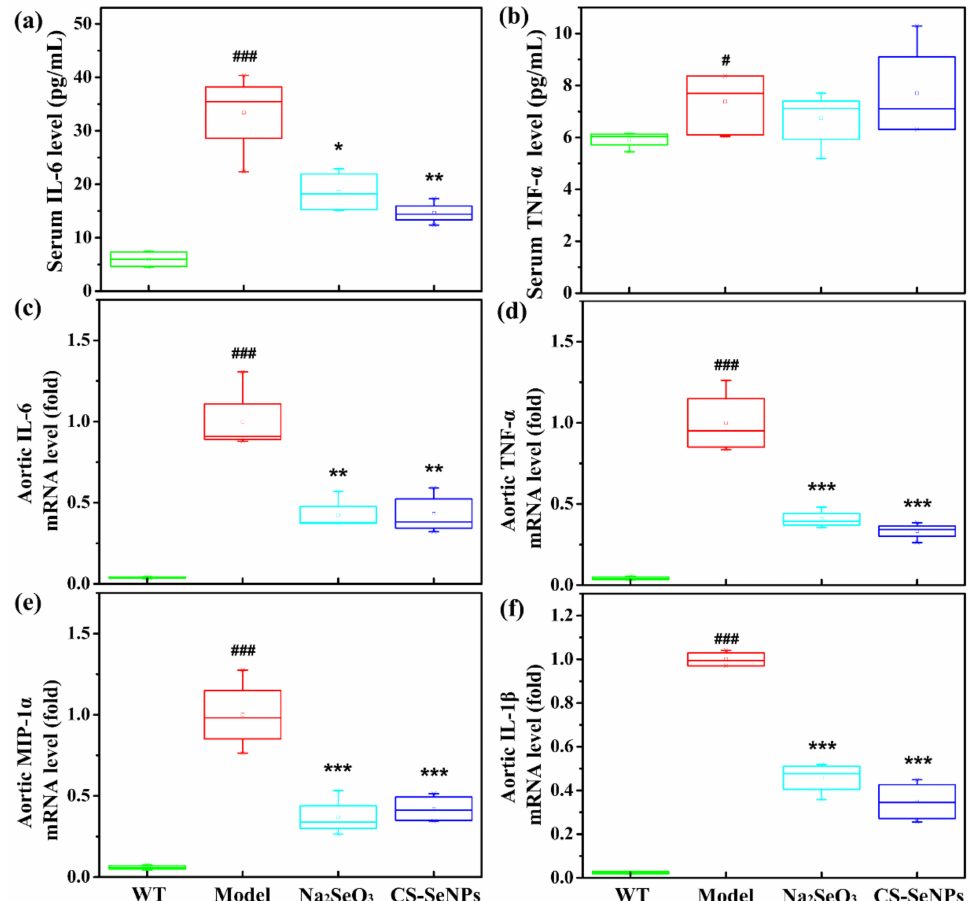
Figure 7. CS-SeNPs and Na 2 SeO 3 inhibited inflammatory response in serum and the aorta. ( a , b ) The levels of serum IL-6 and TNF- α , assayed by ELISA ( n = 8–10); ( c – f ) the mRNA expression levels of IL-6 ( c ), TNF- α ( d ), MIP-1 α ( e ) and IL-1 β ( f ) in the aorta, assayed by qPCR ( n = 4–5). The results were expressed as mean ± SD. # p < 0.05, ### p < 0.001, compared with the WT group. * p < 0.05, ** p < 0.01, *** p < 0.001, compared with the AS model